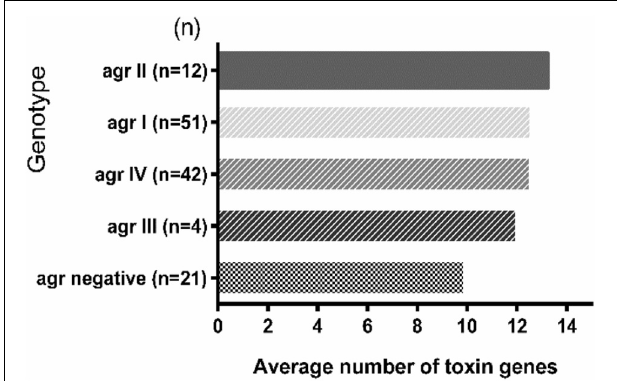
FIGURE 2 | The toxin gene content of S. aureus isolates based on agr genotyping. The average number of toxin genes was calculated based on the total number of toxin genes detected in each agr group divided by the total number of isolates in each agr group. The number in parentheses on the Y -axis represents the total number of isolates in the corresponding agr group.